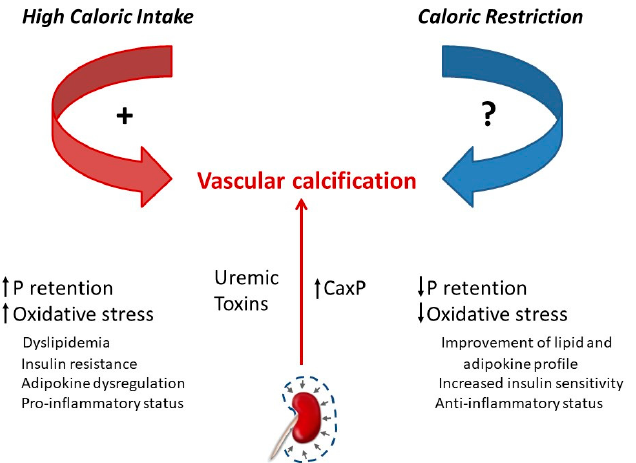
Figure 5. Chronic kidney disease leads to uremic vascular calcification due to increased CaxP product and to a variety of alterations related to uraemia. High caloric intake has been shown to potentiate (+) uremic vascular calcification by several mechanisms including P retention and increased oxidative stress. Although calorie restriction results in metabolic changes opposite to those elicited by high caloric intake, its influence on calcification is not clear (?) because experimental studies have failed to demonstrate a protective effect of calorie restriction on vascular calcification.